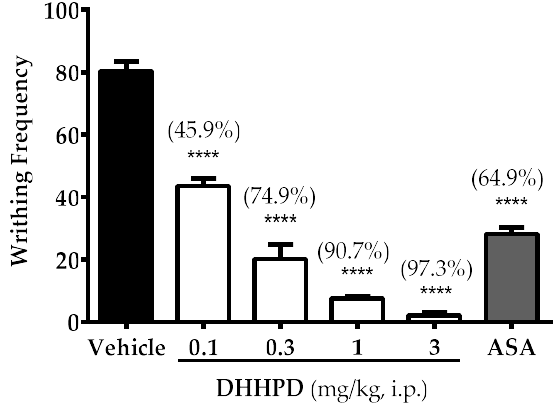
Figure 2. Effect of DHHPD against 0.8% acetic acid-induced abdominal constriction test in mice. Each column denotes the mean ± SEM ( n = 6). The asterisks (*) represent significance level as compared to the vehicle group, **** p < 0.0001 by one-way ANOVA followed by Dunnett’s post hoc test. Mice were administered with vehicle (10 mL/kg, i.p.), acetylsalicylic acid (ASA, 100 mg/kg, i.p.) and DHHPD (0.1, 0.3, 1 and 3 mg/kg, i.p.).